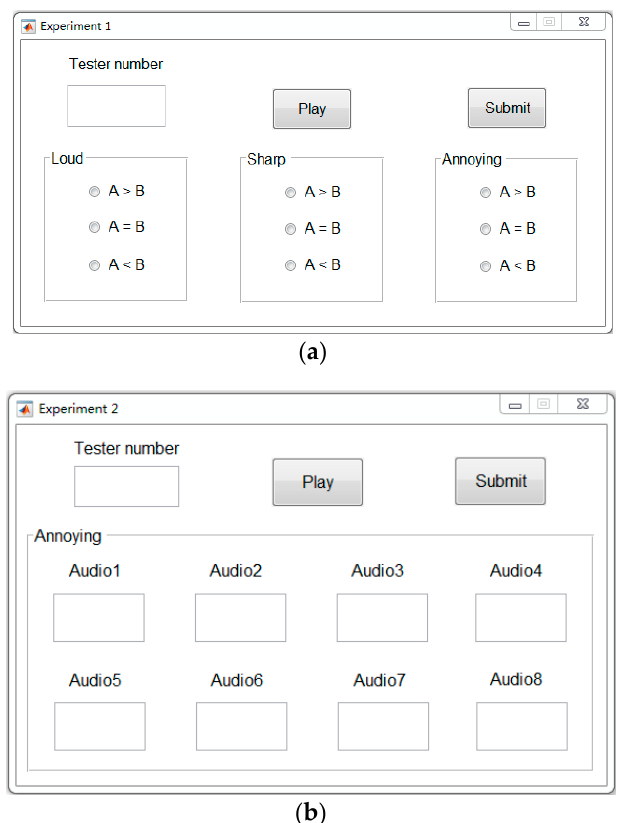
Figure 18. Interactive interfaces of two experiments. ( a ) Interactive interface of audio clips A and B. ( b ) Interactive interface of sub-band audio clips. Table 6. Rating scale definitions of subjective annoying feelings.